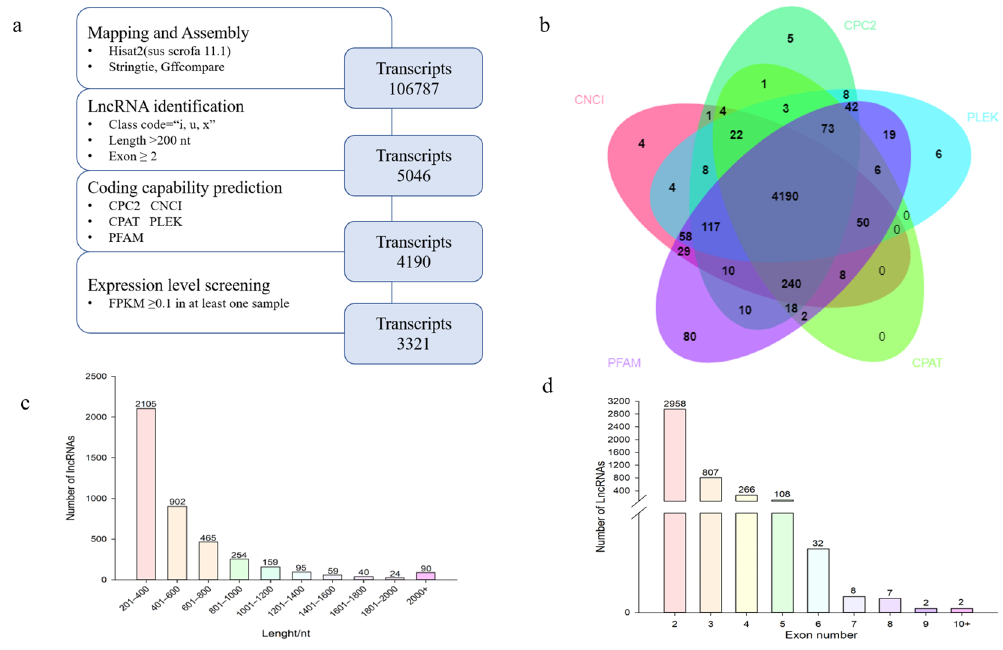
Figure 1. Identification and characterization of lncRNA. ( a ) Process of identifying lncRNA; ( b ) Venn plots of lncRNAs identified from Coding-Non-Coding-Index (CNCI), Coding Potential Calculator 2 (CPC2), predictor of long non-coding RNAs and messenger RNAs based on an improved k-mer scheme (PLEK), Coding Potential Assessing Tool (CPAT), and Pfam databases; ( c ) length distribution of lncRNAs; ( d ) exon number distribution of lncRNAs.